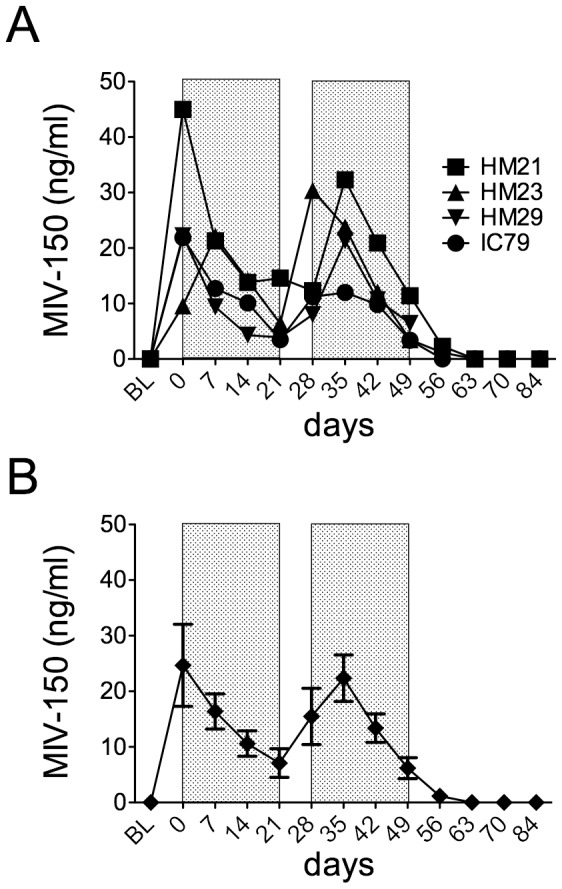
Plasma MIV-150 in animals receiving daily intramuscular injections.MIV-150 injections (0.5 mg/kg/d) were administered for two 21 d periods (with a 7 d break). MIV-150 levels were measured by RIA prior to (baseline, BL) dosing, as well as 3 h after the first injection of each 21 d regimen (d 0 and d 28) and then weekly thereafter just prior to each injection. The shaded areas indicate periods of daily MIV-150 injections. MIV-150 concentrations for individual animals are shown in A while mean concentrations (± SEM) are shown in B. MIV-150 was not detected in placebo-treated animals (not shown).